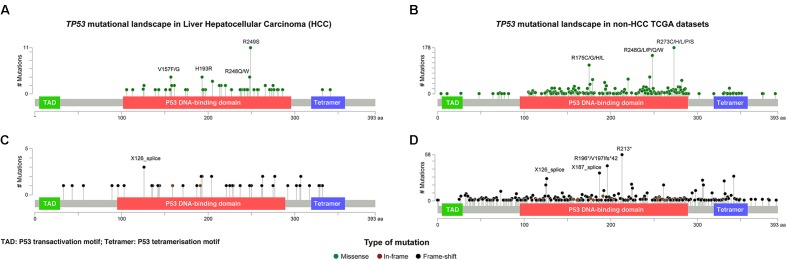
The distribution and the spectrum of TP53 mutations. The distribution and spectrum of TP53 missense (A,B) and deleterious (C,D) mutations in hepatocellular carcinoma (A,C) and in non-liver TCGA datasets (B,D). Diagrams represent the protein domains of p53 encoded by the TP53 gene. The presence of a mutation is shown on the x axis (lollipop), and the frequency of mutations is shown on the y axis. Missense mutations are presented as green circles, deleterious mutations (i.e., nonsense, frameshift, splice-site and in-frame) are depicted in black and brown circles. Plots were generated using cBioPortal tools (http://www.cBioPortal.org) and curated manually.